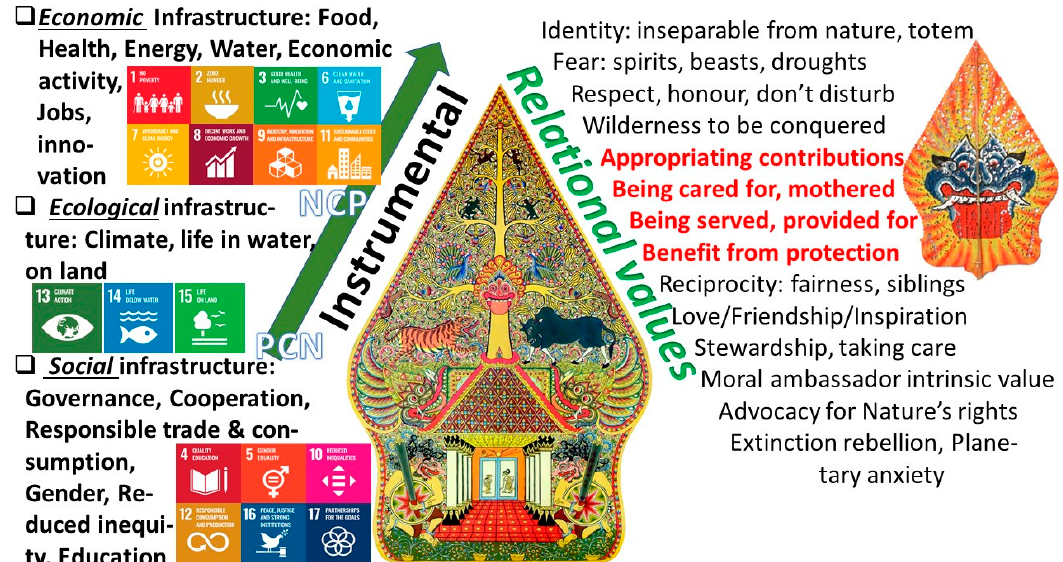
Figure 8. Instrumental as part of relational values of nature from a human perspective as exemplified in the Javanese gunungan representation with its idyllic harmony and fearful disaster side, and the UN Sustainable Development Goals; NCP = Nature’s contributions to people, PCN = People’s contributions to nature.